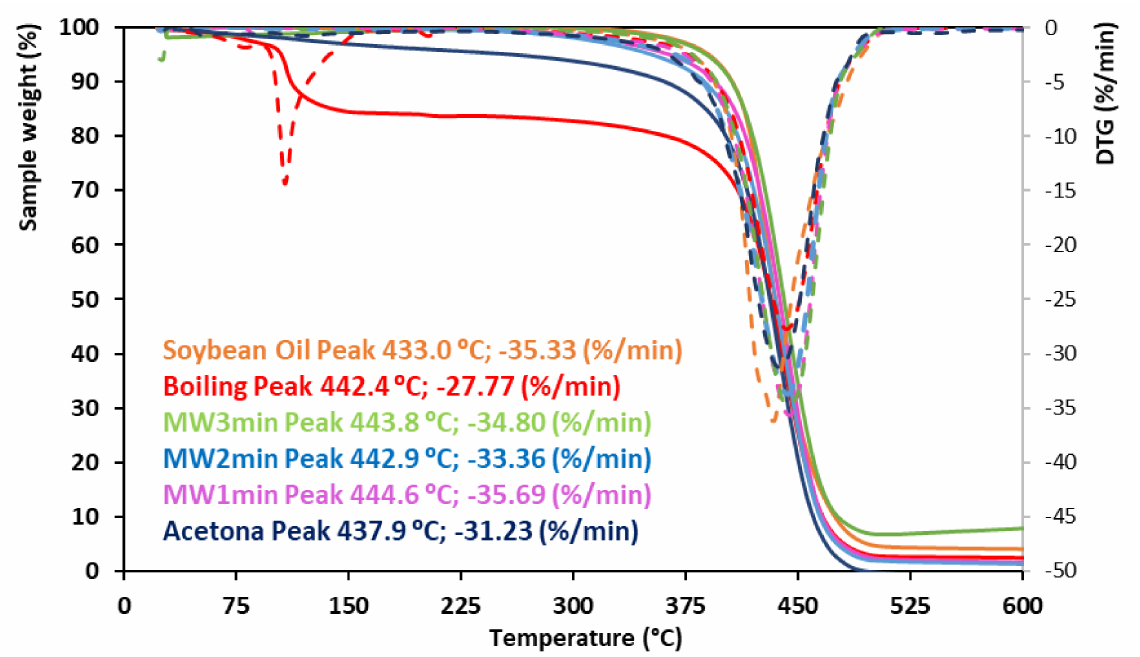
Figure 6. Thermal stability and moisture content of the extracted tallows and soybean oil, assessed by